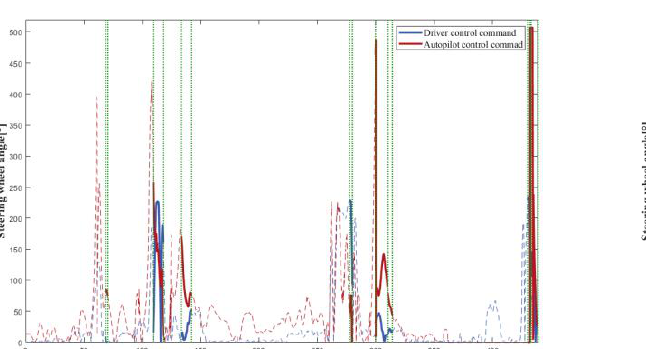
( b ). Trigger based on the instantaneous discrepancy value. Figure 12. The 2nd round test results for longitudinal control command discrepancy data trigger recording.